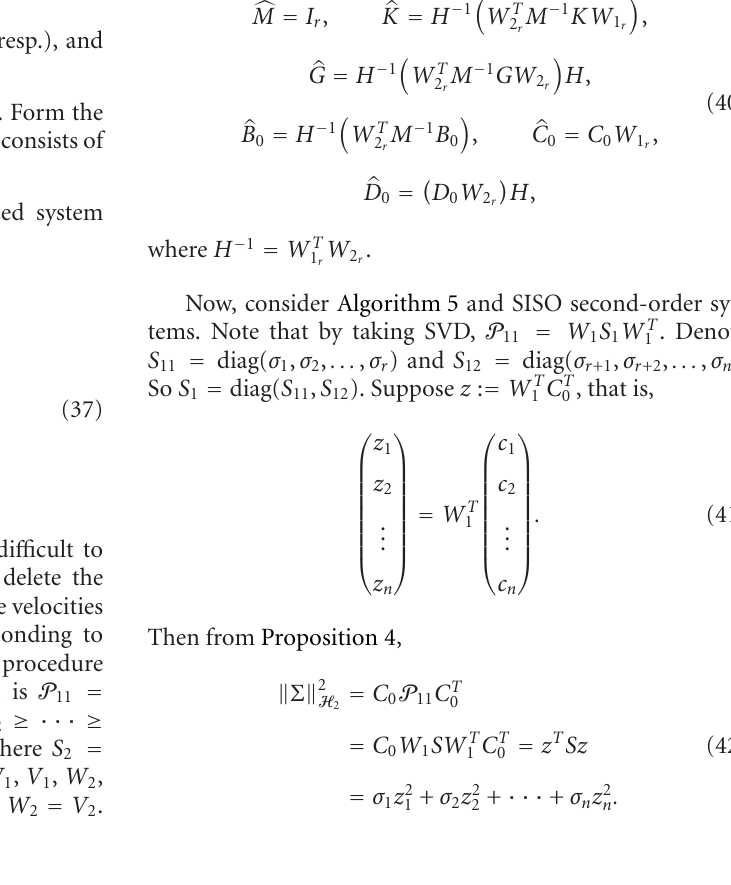
Algorithm 5 (Second-order model reduction—SVD on P 11 (or, P 22 , Q 11 , and Q 22 , resp.)).